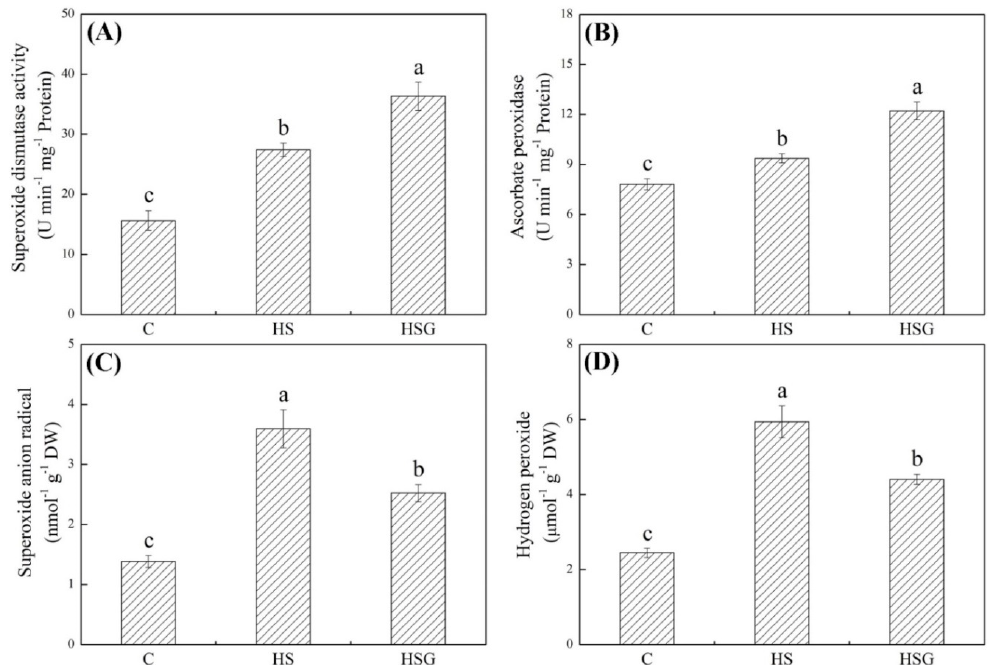
Figure 3. E ff ects of exogenous γ -aminobutyric acid (GABA) on ( A ) superoxide dismutase (SOD) activity, ( B ) ascorbate peroxidase (APX) activity, ( C ) superoxide anion radical (O 2 − ), and ( D ) hydrogen peroxide (H 2 O 2 ) in leaf of creeping bentgrass under heat stress. Vertical bars indicate ± SE of mean ( n = 4) and di ff erent letters above columns indicate significant di ff erences ( p ≤ 0.05). C, control (normal condition); HS, heat stress; HSG, heat-stressed plants pretreated with